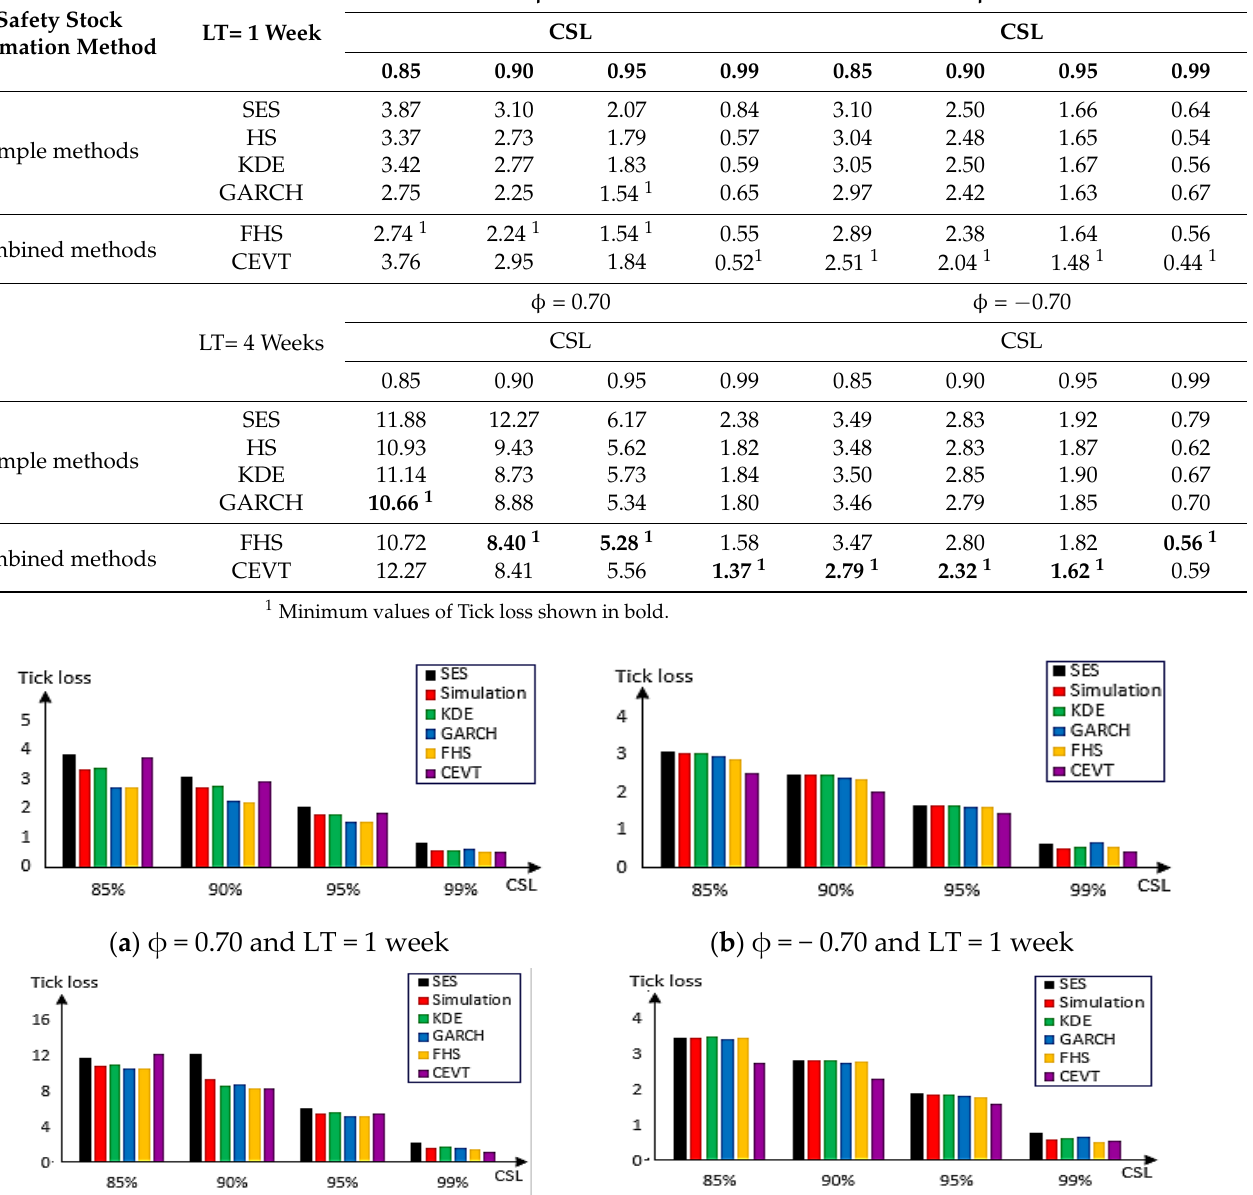
Figure 7. Tick loss values in the case of gamma distribution for ϕ = 0.70 (a and c) and ϕ = − 0.70 (b and d) and lead times of one week ( a , b ) and four weeks ( c , d ).